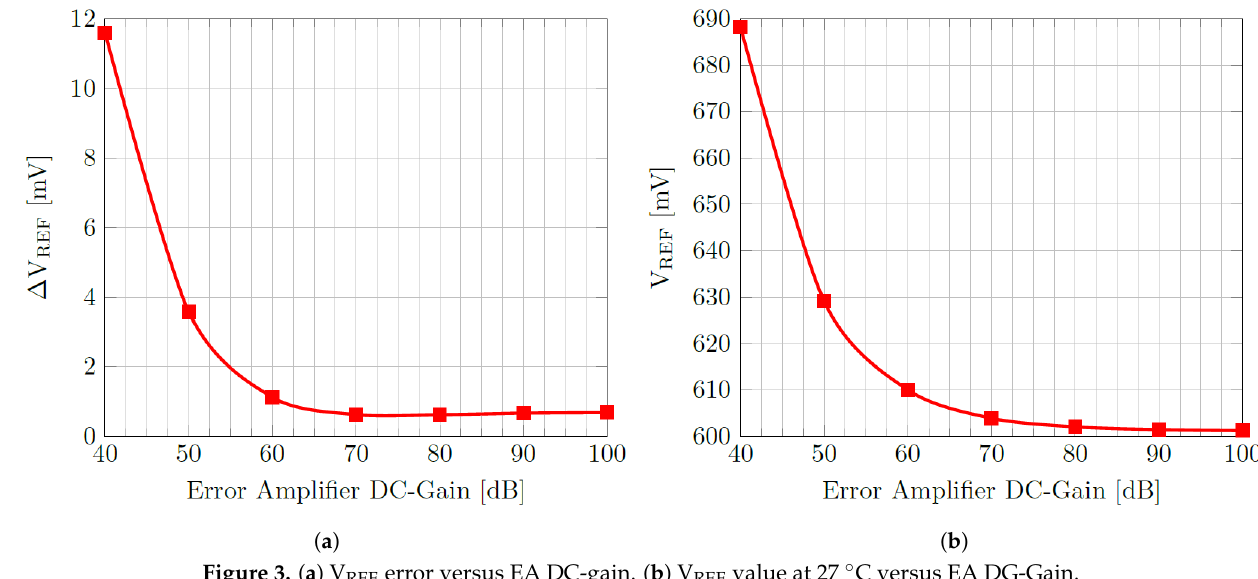
Figure 3. ( a ) V REF error versus EA DC-gain. ( b ) V REF value at 27 ◦ C versus EA